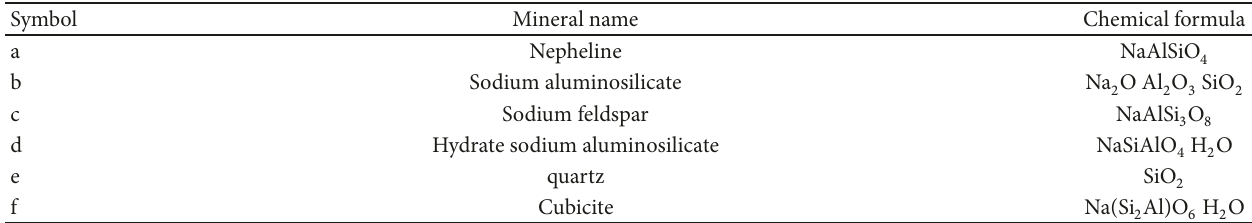
Table 2: The phase corresponding to XRD